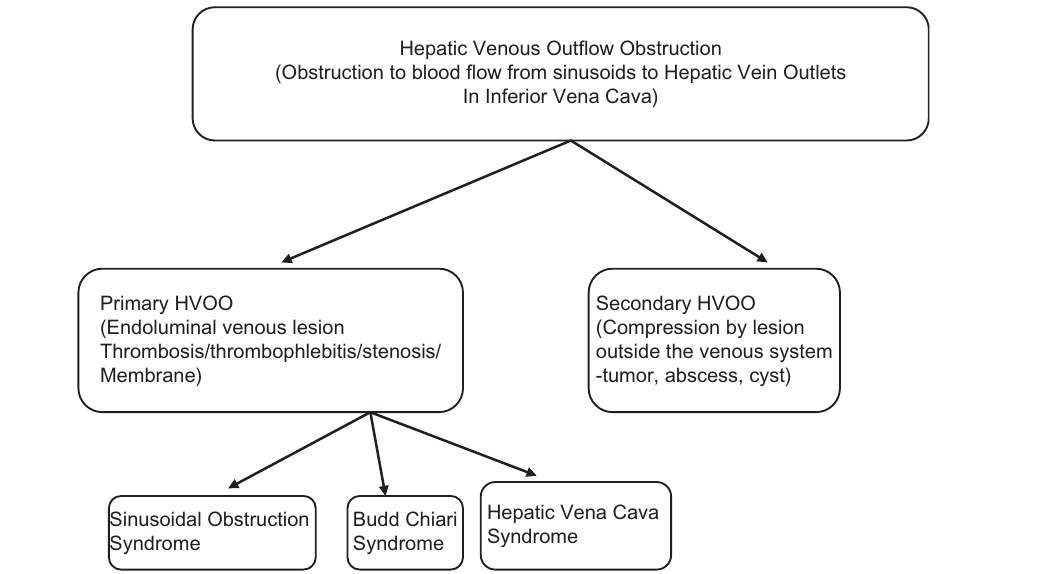
Figure 2. Suggested classi fi cation of hepatic venous out fl ow